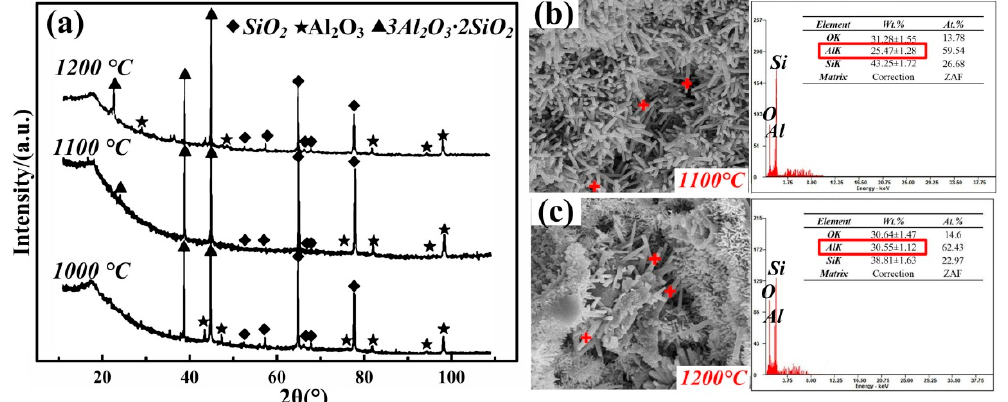
Figure 3. ( a ) X-ray diffraction (XRD) patterns of sample 4 at 1000, 1100, and 1200 °C. ( b , c ) Energy spectrum analysis of whiskers at 1100 and 1200 ◦ C, spectrum analysis of whiskers at 1100 and 1200 °C, respectively.